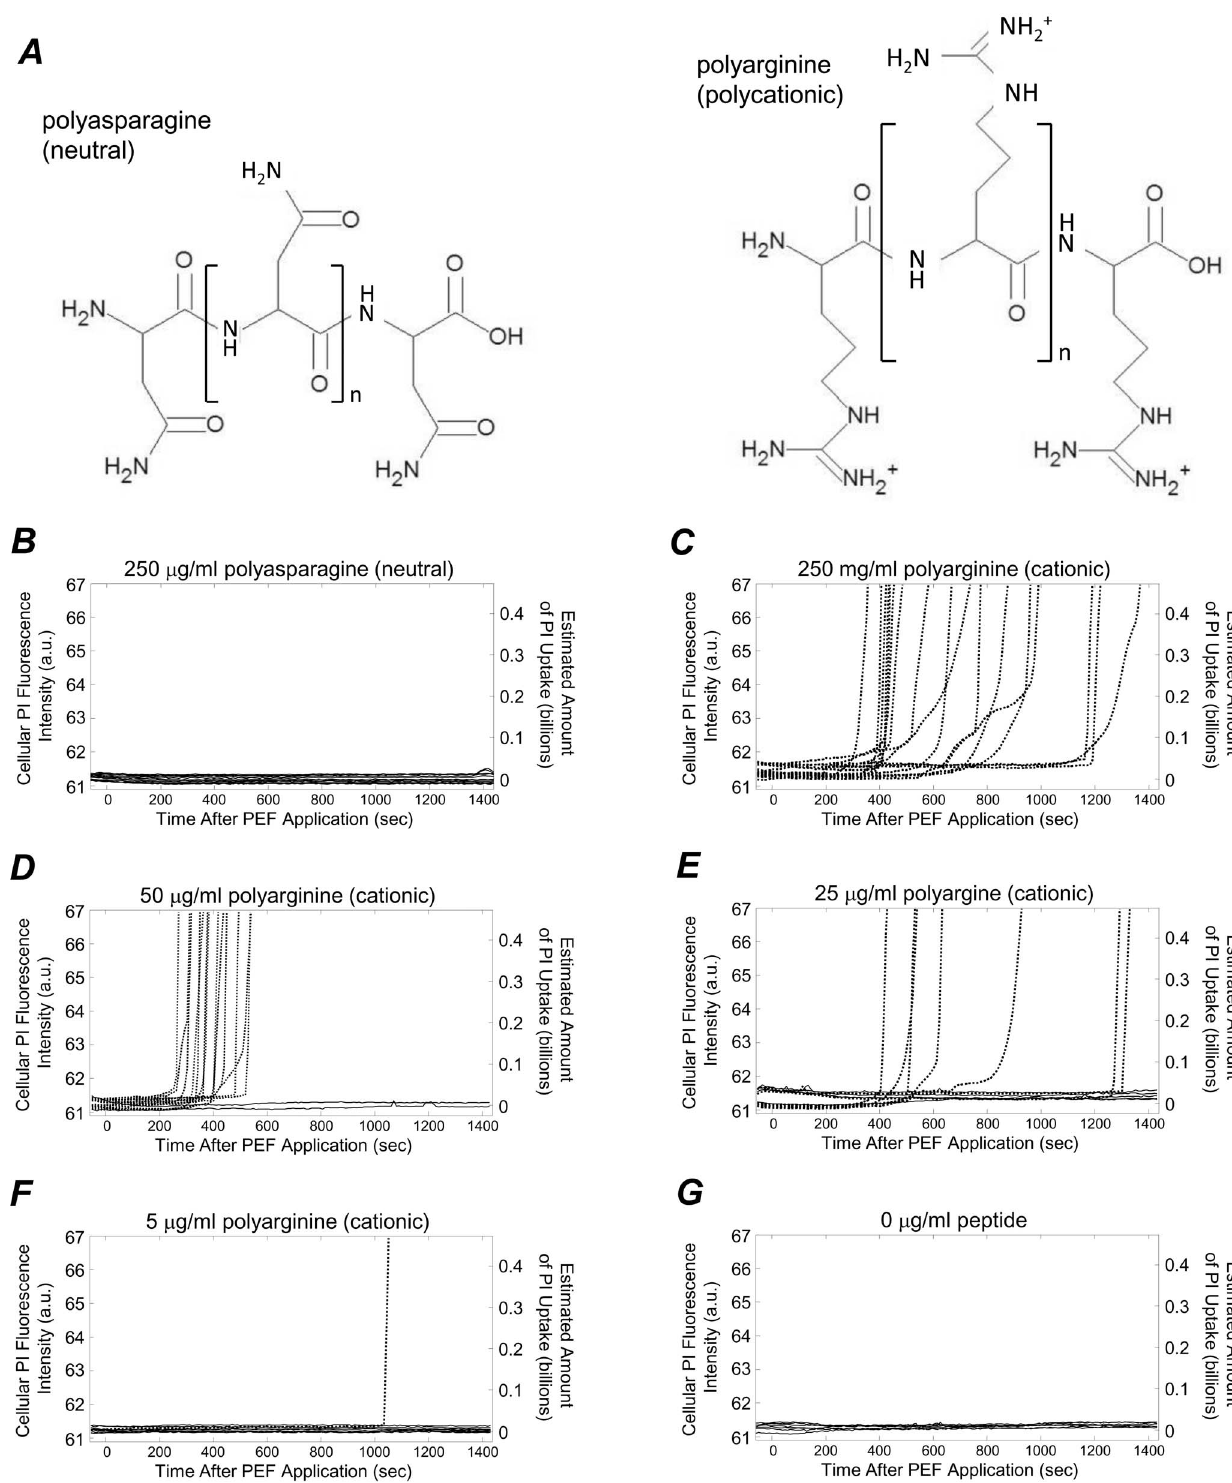
Figure 8. Cationic peptide exposure alone influenced membrane permeability to PI. A : Cells were exposed to a peptides composed of neutral residues at neutral pH (polyasparagine, at left) and peptides with cationic residues at neutral pH (polyarginine, at right). These two peptides were of the same molecular weight. When 250 m g/ml of neutral polyasparagine or cationic polyarginine was added to cell media at 2 60 seconds, cells either fluoresced at baseline levels ( B ) or internalized PI in delayed, accelerating, and high levels ( C ). D – G : Reducing the cationic peptide concentration reduced the number of cells that internalized PI during the course of the experiment, and increased the delay time observed for abrupt, accelerated, high-level PI uptake. In B – G , the number of cells examined was 15, 18, 16, 14, 11, and 22, respectively.